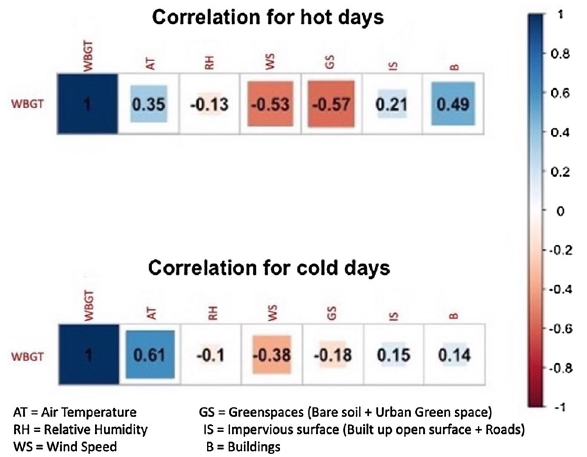
Figure 6. Pearson correlation coefficient (r) between meteorological variables and land cover types with